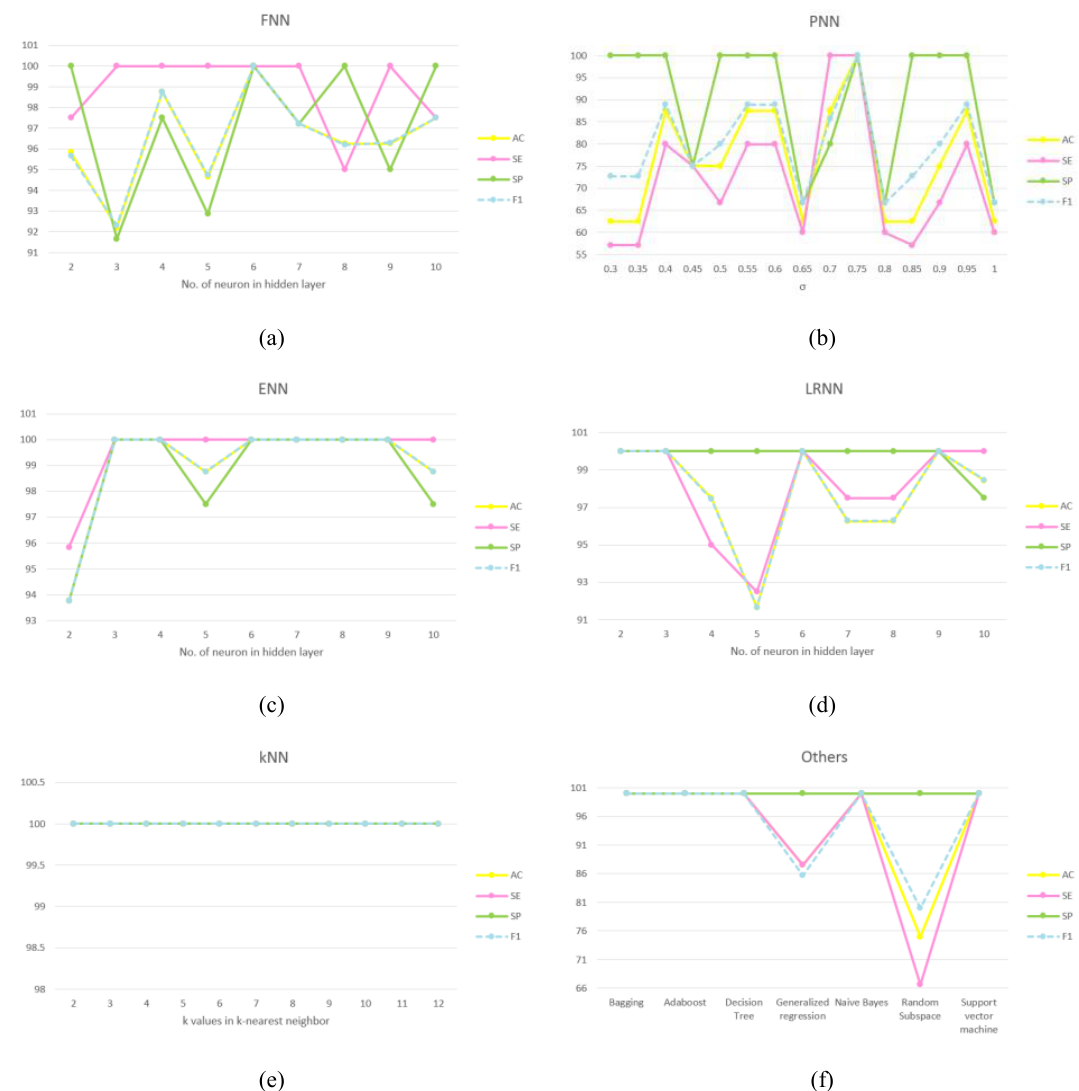
Figure 6. The Performance of Different ML Schemes in Discrimination Between COPD and Controls Using 10-Fold CV: (a) FNN, (b) PNN, (c) ENN, (d) LRNN, (e) kNN, and (f) other remaining approaches including DT, EMs, GRNN, SVM, and NB. Note . ML: Machine learning; COPD: Chronic obstructive pulmonary disease; CV: Cross-validation; FNN: Feed-forward neural network; PNN: Probabilistic neural network; ENN: Elman neural network; LRNN: Layer recurrent neural network; kNN: k-nearest neighbor; DT: Decision tree; EM: Ensemble method; GRNN: Generalized regression neural network; SVM: Support vector machine; NB: Naive